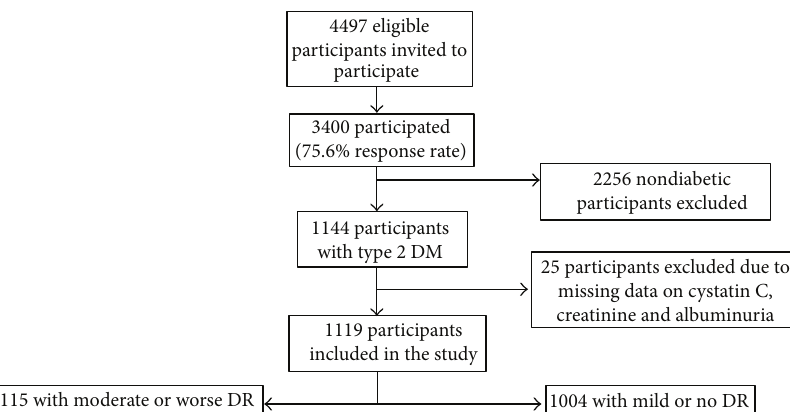
Figure 1: Flow diagram of study enrolment. All participants of Indian ethnicity were eligible unless he/she had moved from the residing address, had not lived at the official address in the past six months, or was terminally ill (e.g., cancer) or deceased.